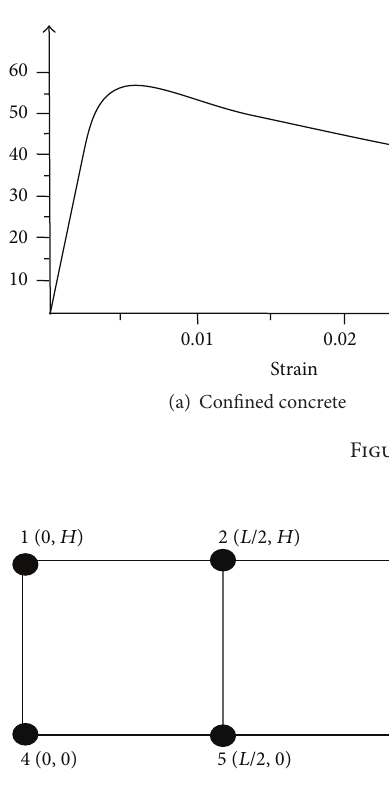
Figure 3: Modeling of concrete element.